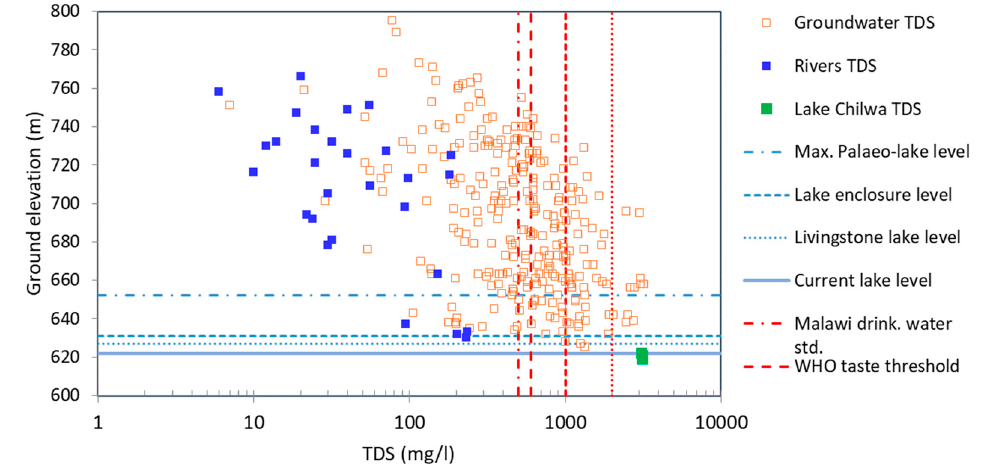
Figure 11. Plot of Basin ground elevation versus Phalombe District observed TDS for groundwater, surface water and Lake Chilwa samples.